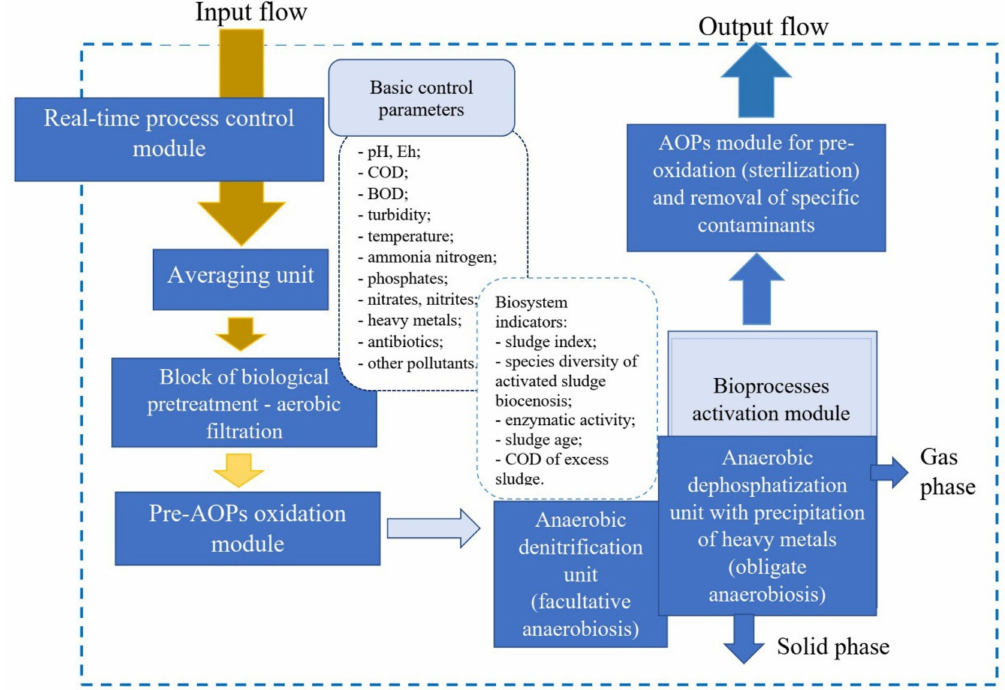
Figure 9. Integrated formalized model of the combination of biological processes and AOPs in wastewater